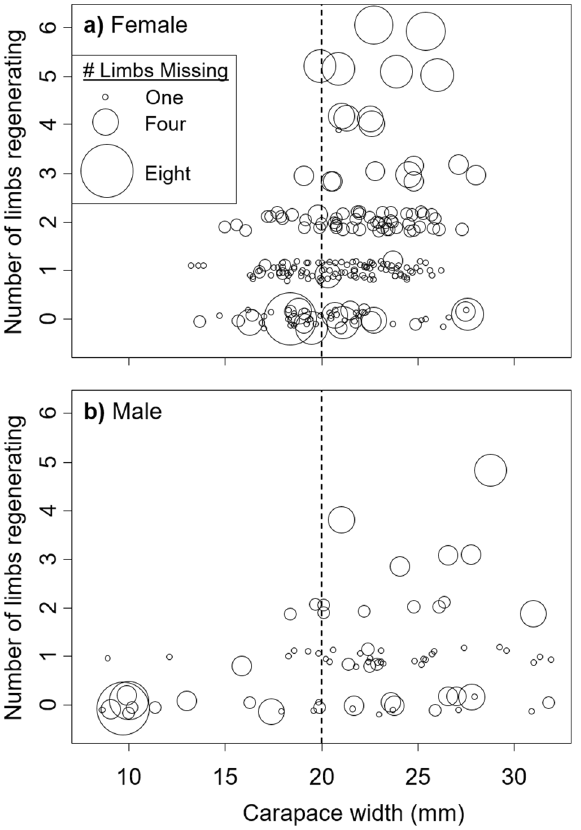
Figure 6. Number of limbs regenerating for female ( a ) and male ( b ) Hemigrapsus sanguineus from the 2019 sampling in New Hampshire as a function of CW. Circle size shows the relative number of missing limbs, as indicated in the inset box. The dashed vertical line shows the cutoff used in the analysis to examine crabs < 20 mm or ≥ 20 mm